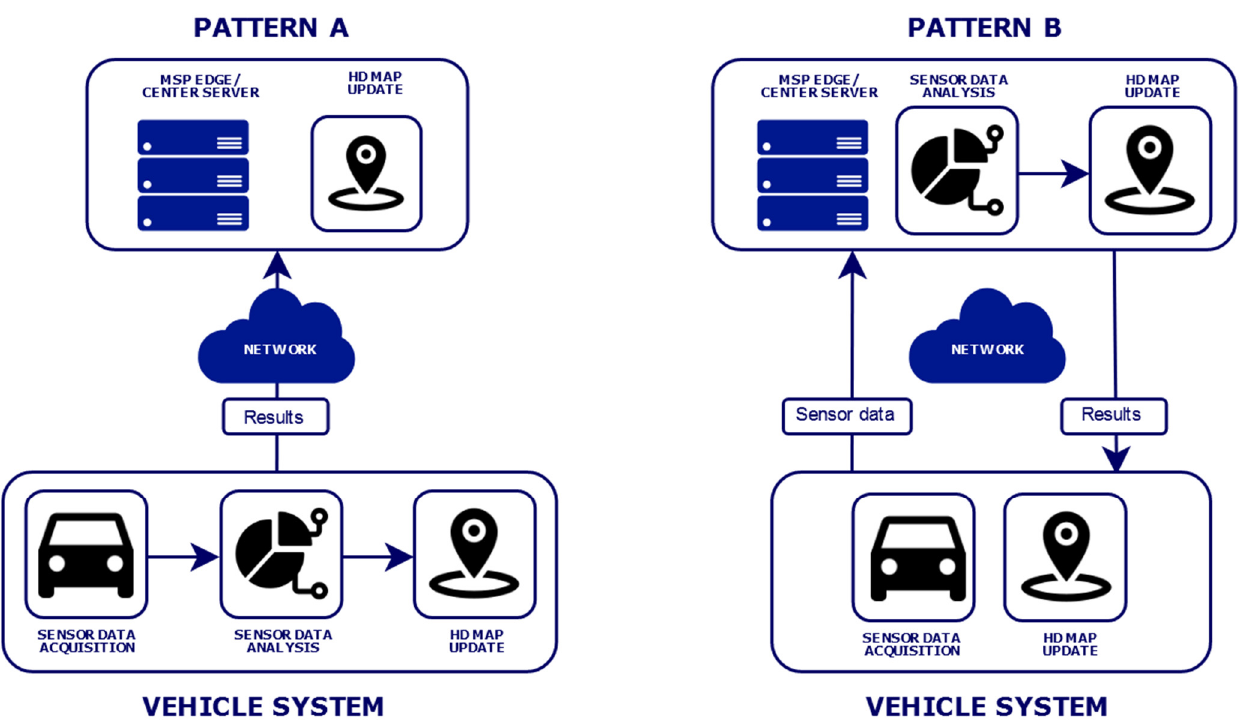
Figure 9. Patterns A and B of updating data of HD maps based on [28].